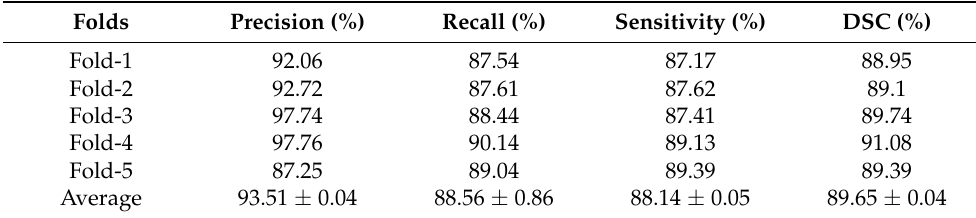
Table 2. Five-fold cross validation results of the trained segmentation model. Folds